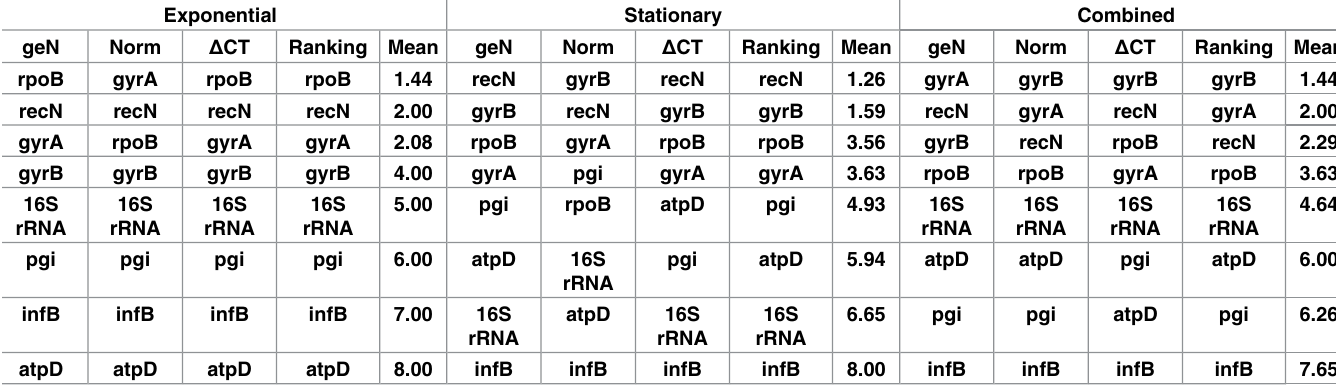
Table 11. Candidate reference genes ranked by different methods in